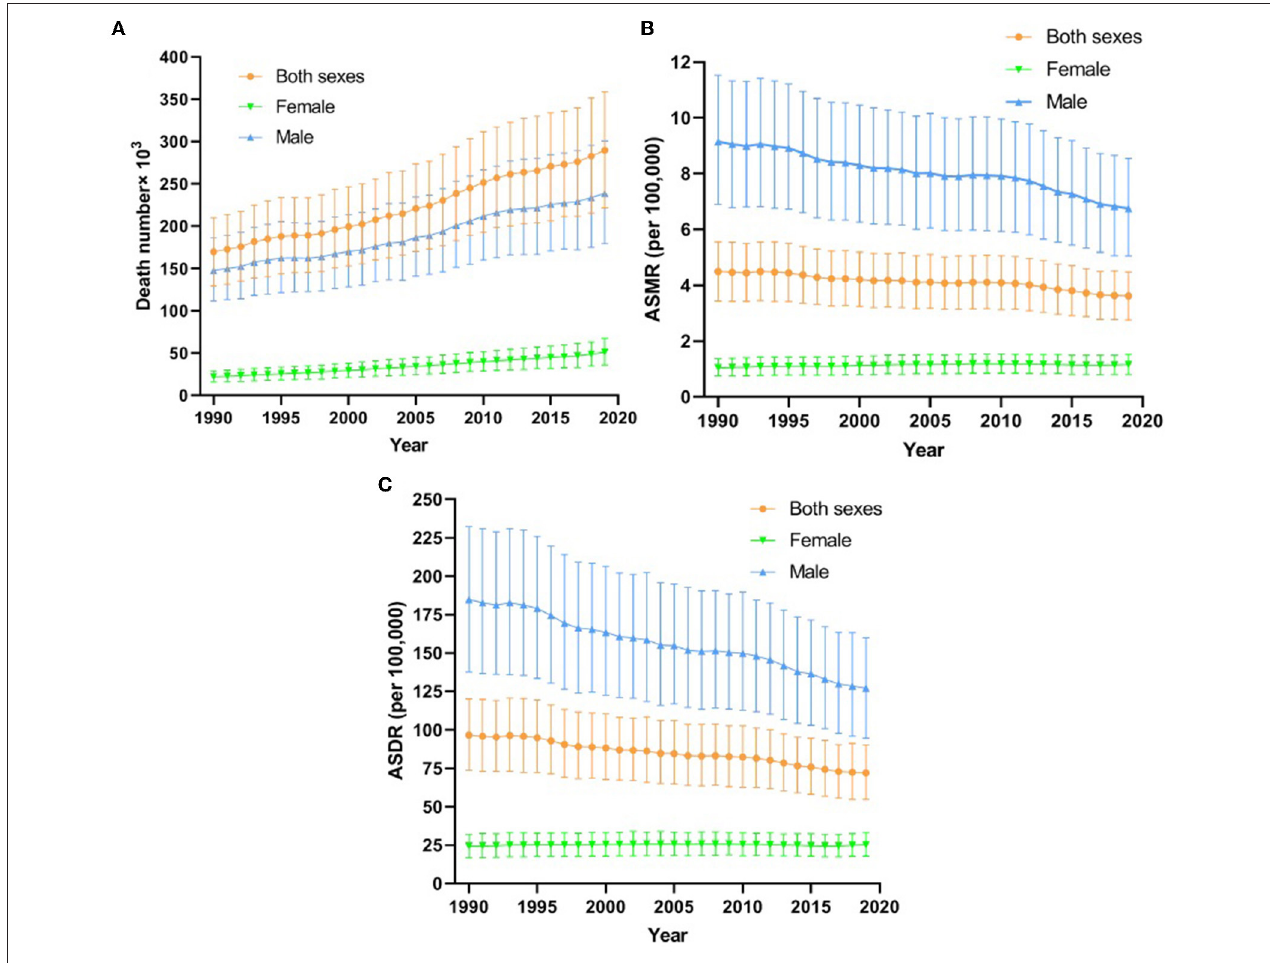
FIGURE 1 | The deaths number (A) , ASMR (B) and ASDR (C) for TBL cancer from 1990 to 2019. DALY, disability adjusted life year; TBL cancer, tracheal, bronchus and lung cancer; ASMR, age-standardized mortality rates; ASDR, age-standardized DALY